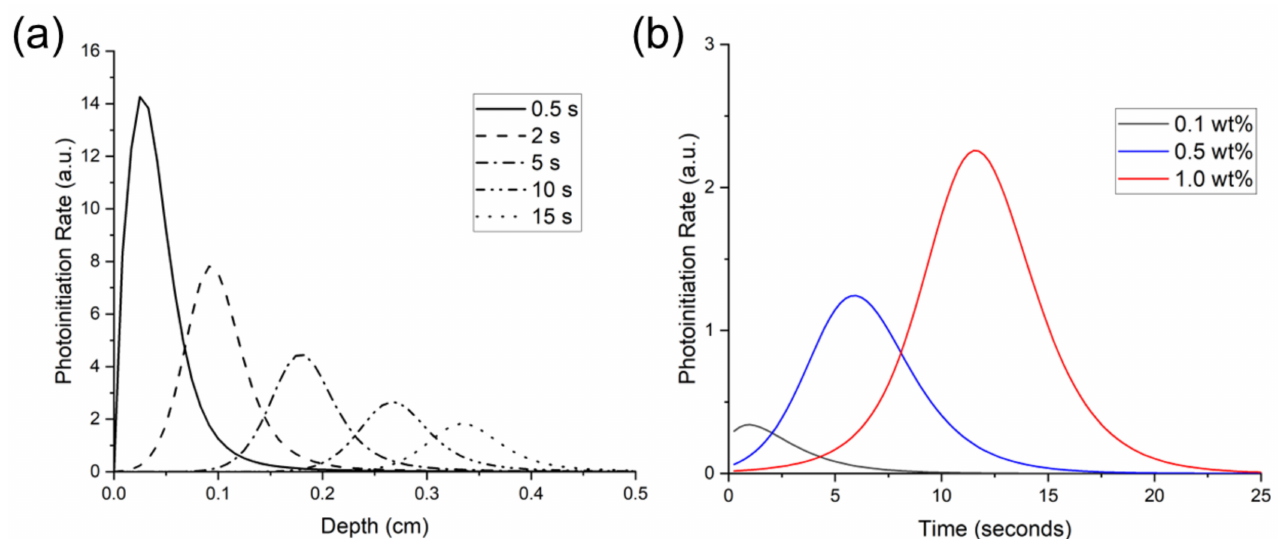
Figure 6. Predicted photoinitiation rate for BAPO system in an 80:20 blend of Bis-EMA:PETIA. ( a ) depicts the temporal and spatial evolution of photoinitiation as the BAPO photobleaches at 1.0 wt% concentration, and ( b ) depicts the rate over time at a 3-mm depth with varying BAPO